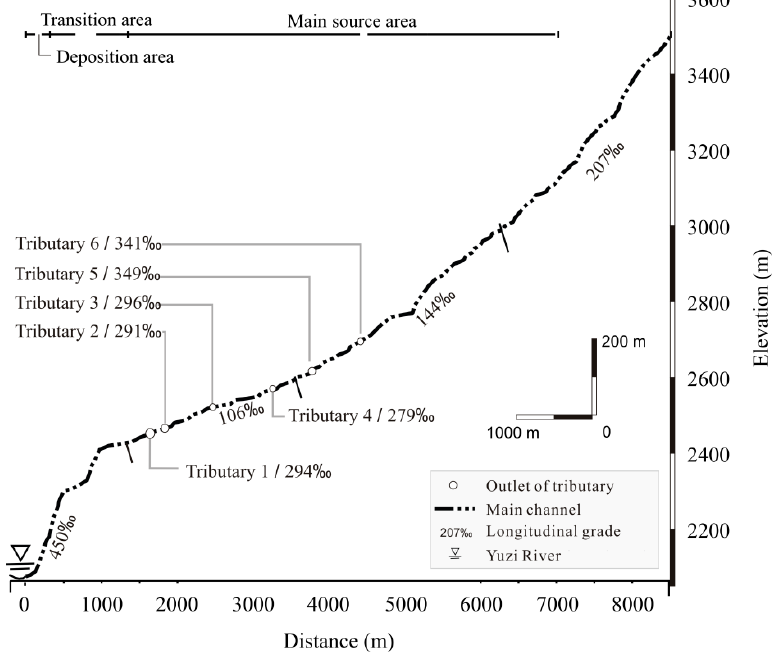
Figure 4. Longitudinal slope line of Xiongmao Gully and longitudinal gradient diagram.